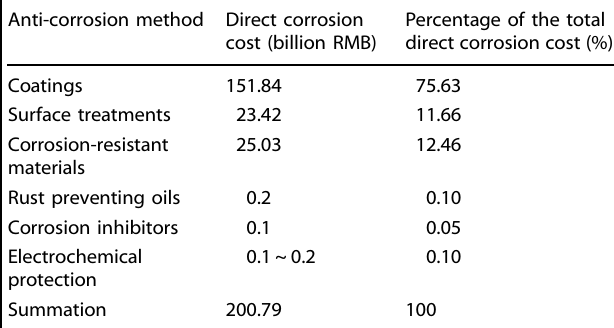
Table 3. The cost of corrosion in the 2002 national survey in